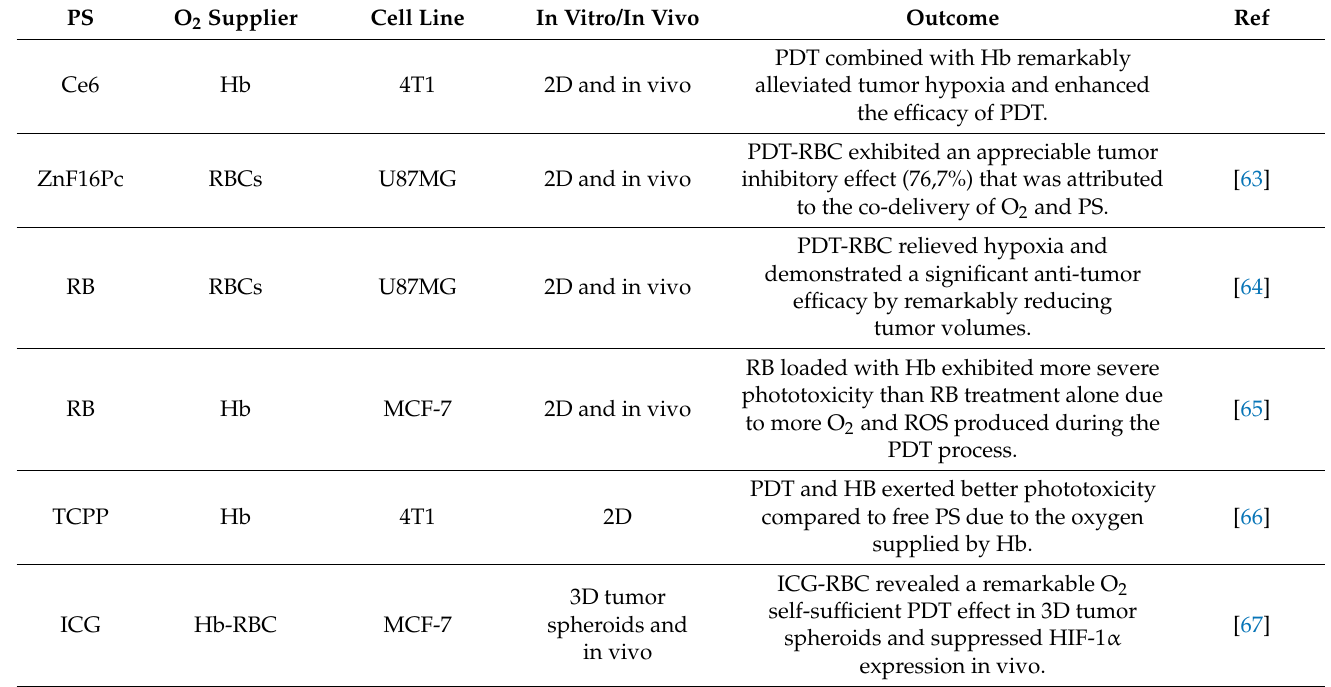
Table 2. Summary of studies that have used RBC for O 2 supply in